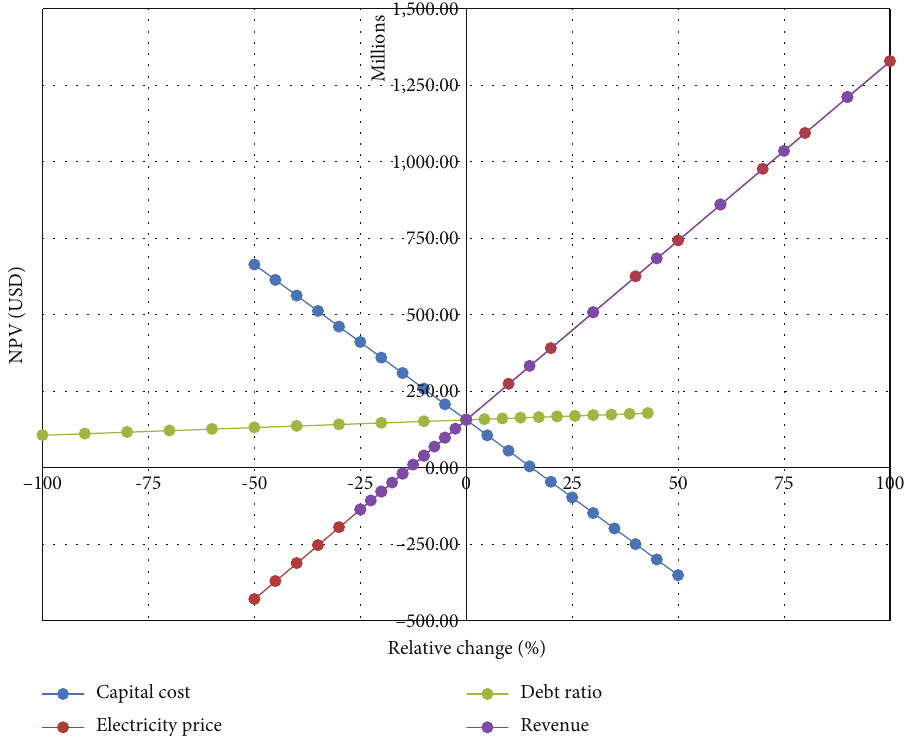
Figure 12: Relationship between relative changes in capital cost, electricity price, and revenue with the NPV.